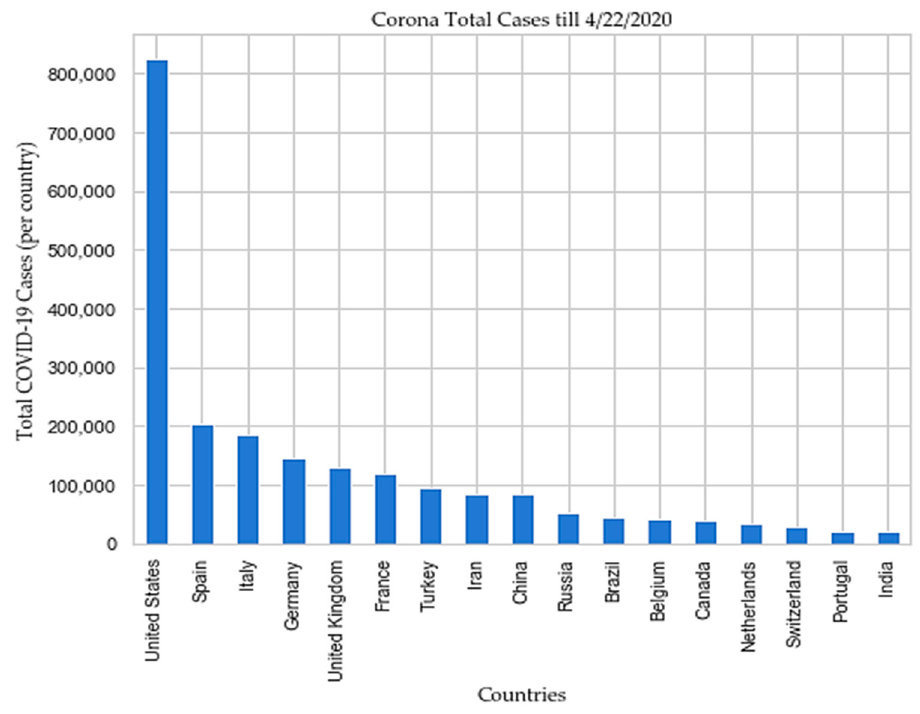
Figure 3. Top 17 countries according to the total cases reported till 22 April 2020.